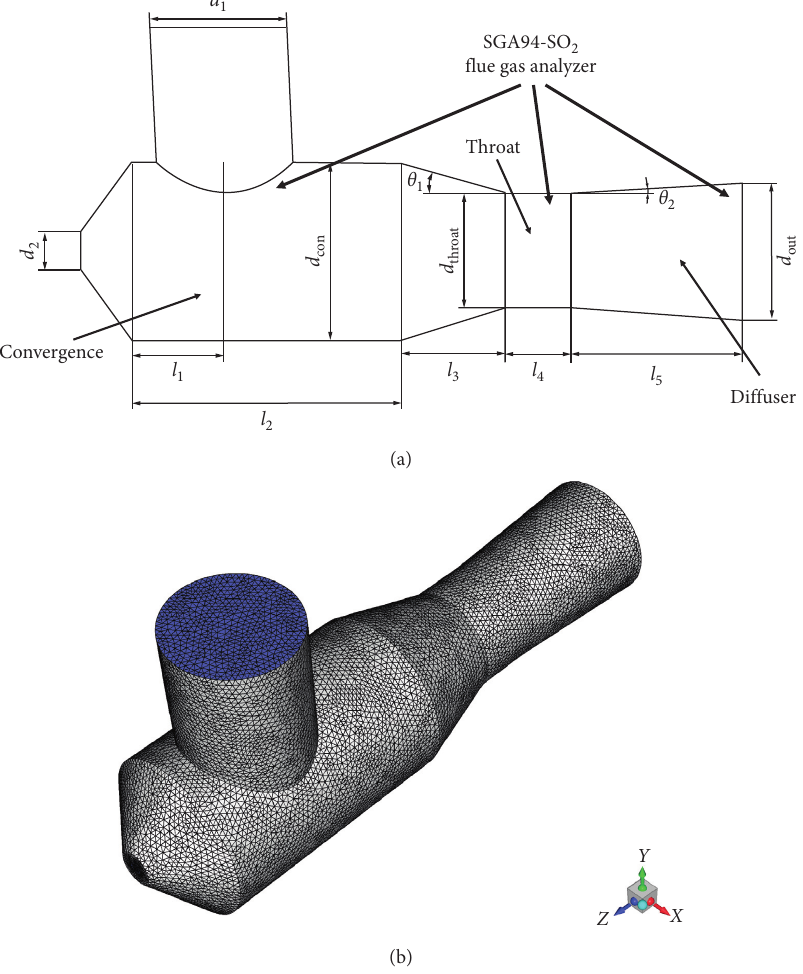
Figure 2: (a) Schematic diagram. (b) Meshing diagram.